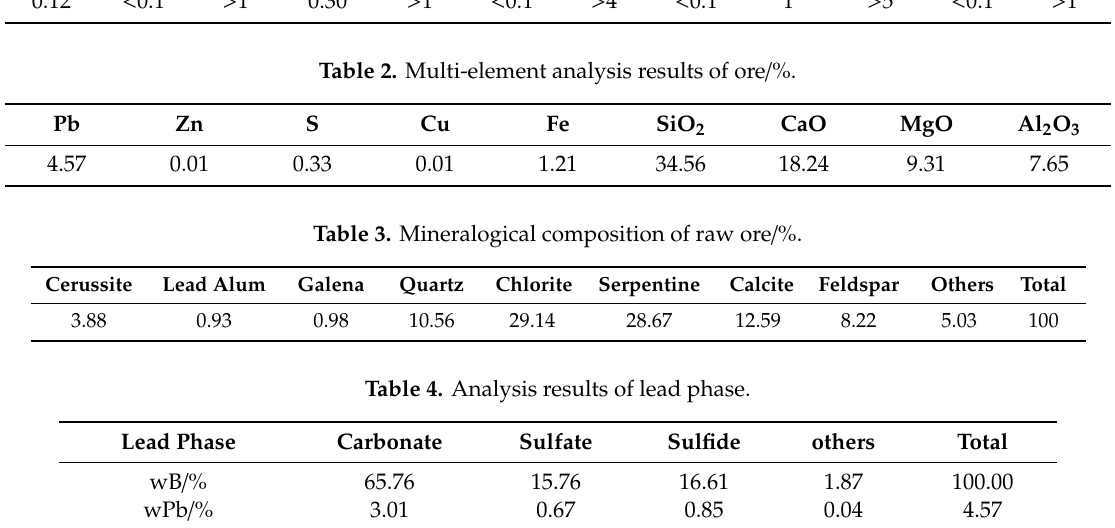
Table 1. Spectrum Analysis results of raw ore / %.